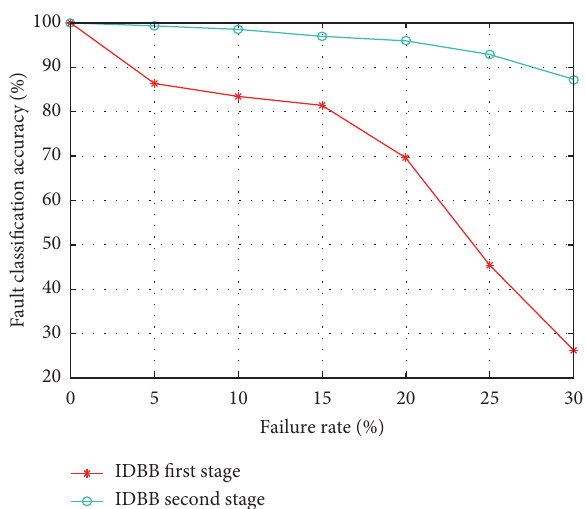
Figure 6: Trend of the accuracy rate of fault classification in two stages of fault detection varies with the fault